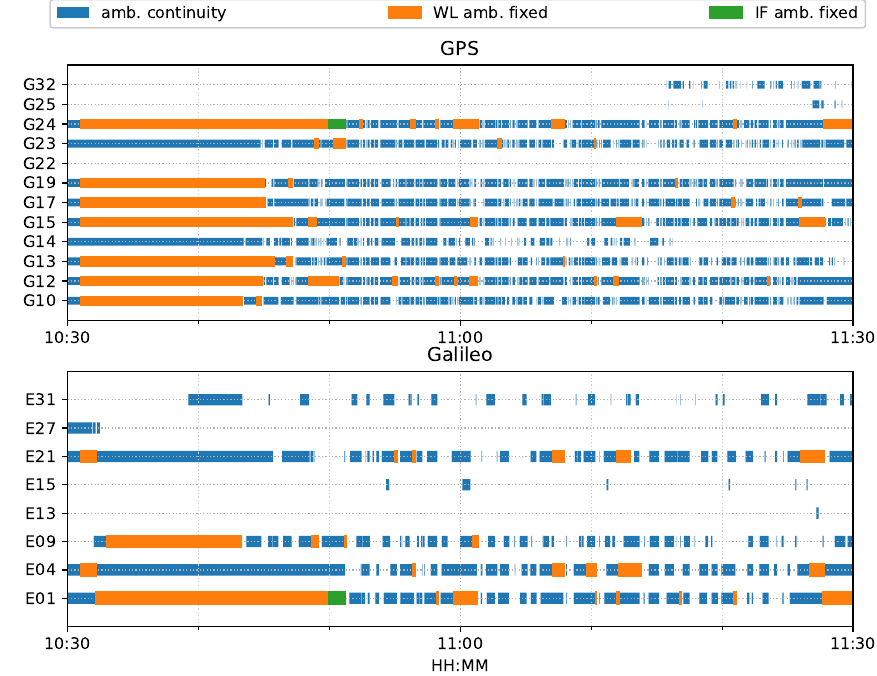
Figure 15. Phase ambiguity status of road bridge test on 11 February 2022.